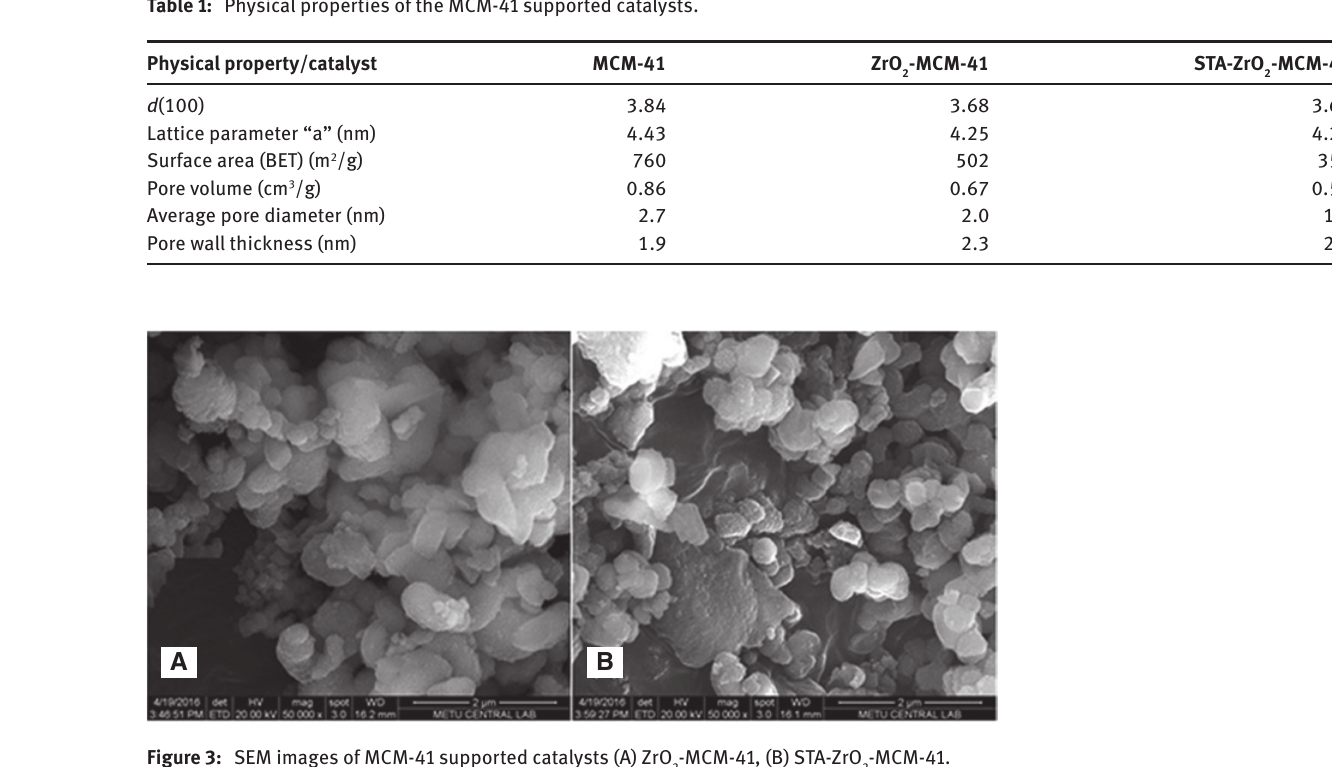
Figure 3: SEM images of MCM-41 supported catalysts (A) ZrO